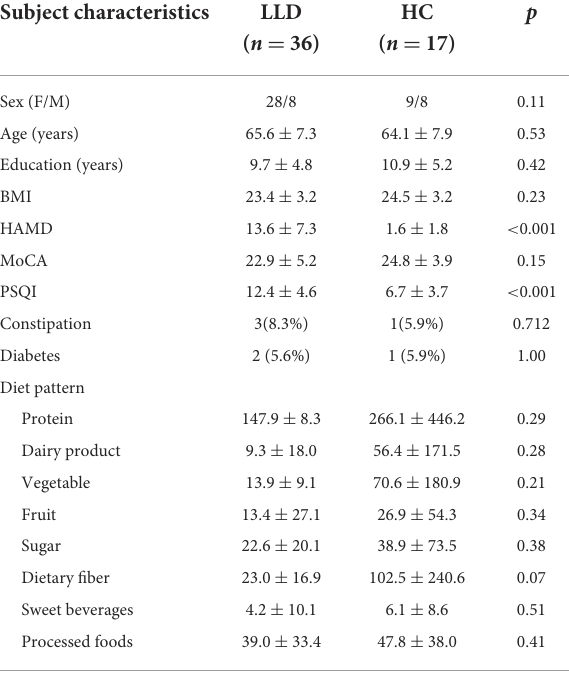
TABLE 2 Demographic and clinical data of the patients with late-life depression (LLD) and healthy controls